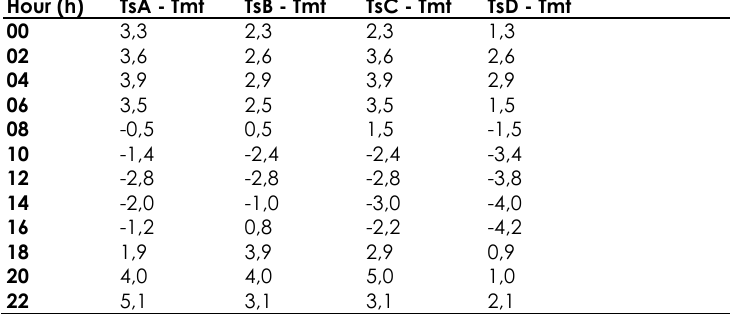
Table 3. Temperature discrepancies between the air in four surveyed houses (TsA, TsB, TsC and TsD) and meteorological temperatures (Tmt) Hour (h) TsA -